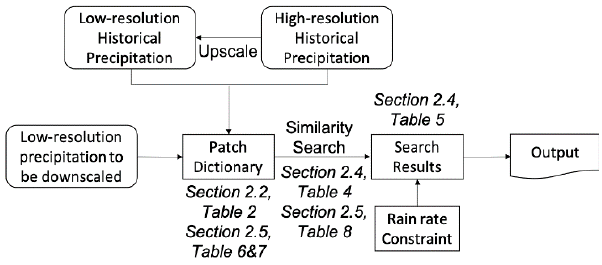
Figure 1. PreciPatch method workflow.